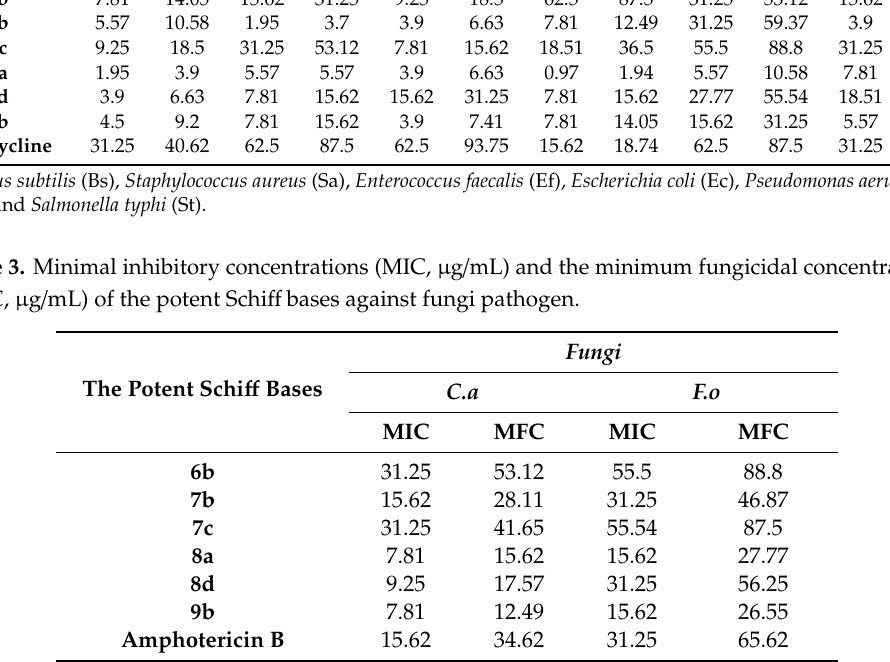
Table 2. Minimal inhibitory concentrations (MIC, µ g / mL) and the minimum bactericidal concentrations (MBC, µ g / mL) of the potent Schi ff bases against bacterial pathogens. The Potent Schi ff Bases